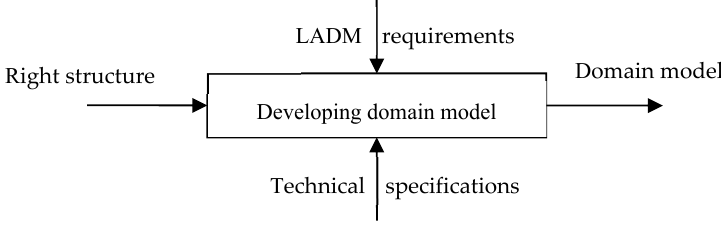
Figure 5. Inputs and output of the analysis process of developing the rights structure.